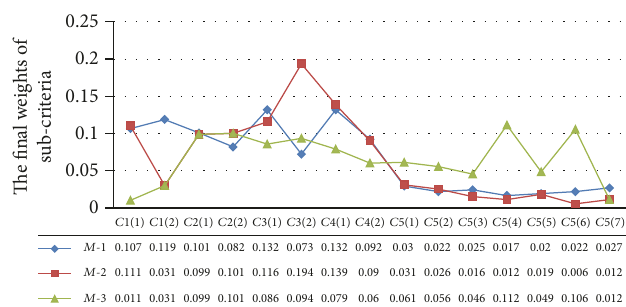
Figure 5: The weight values of evaluation criteria based on different situations.